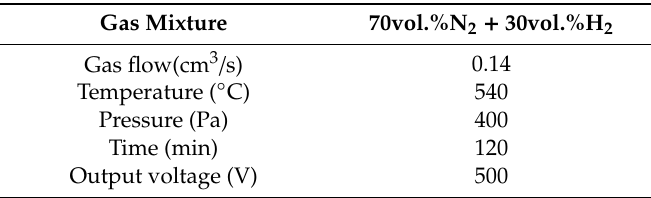
Table 4. Parameters used in the plasma nitriding